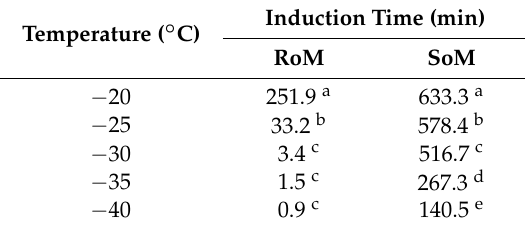
Results are expressed as the mean of four trials. Mean values with superscripts containing different letters in the same column are significantly different ( p < 0.05). RoM, rapeseed oil mayonnaise; SoM, soybean oil mayonnaise.